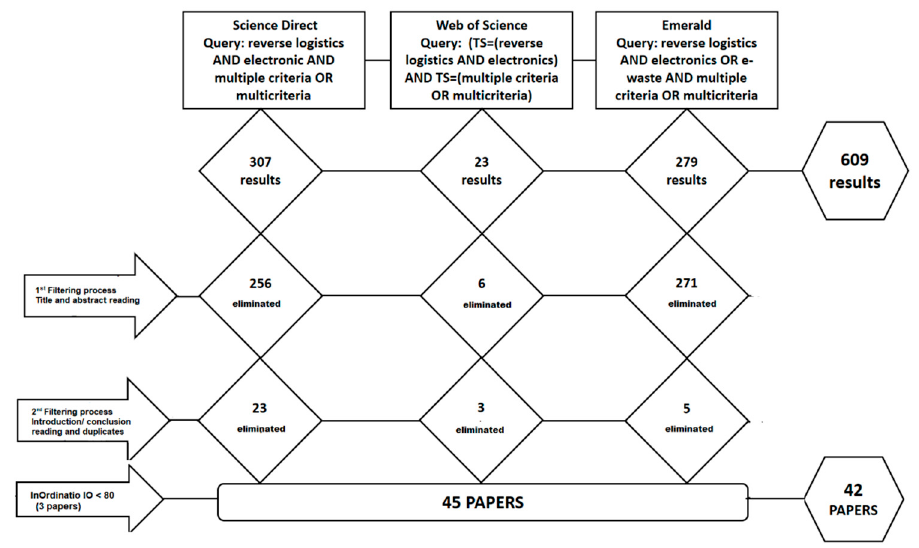
Figure 1. The filtering process of systematic literature review (SLR).